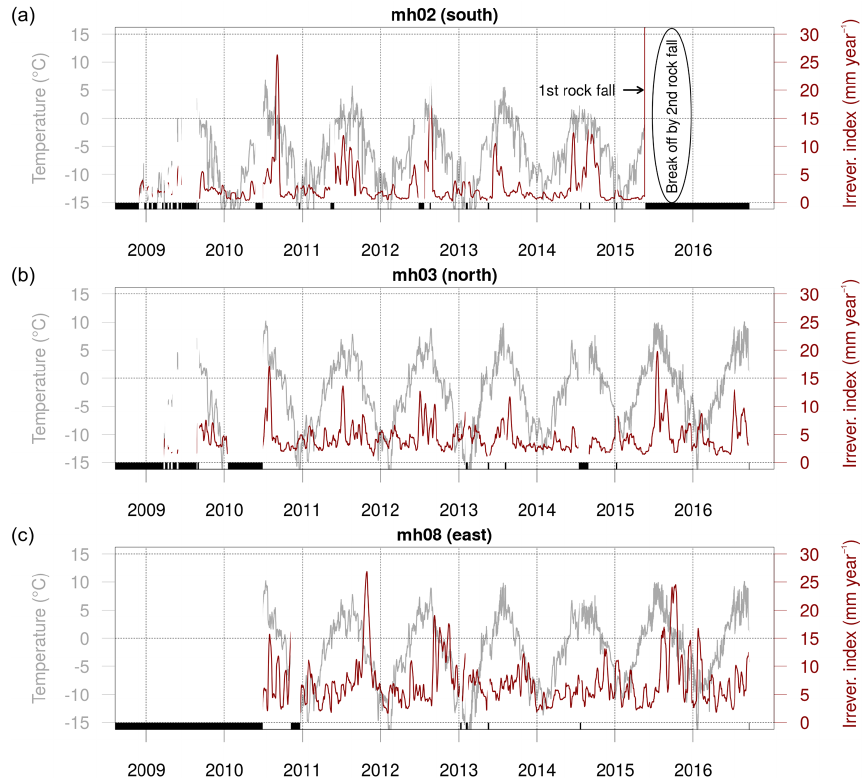
Figure 10. Irreversibility index for (a) location mh02 (south), (b) location mh03 (north) and (c) location mh08 (east, on ridge) as an indicator for periods, where the irreversible displacement dominates. Black bars indicate periods where no or reduced data are available.